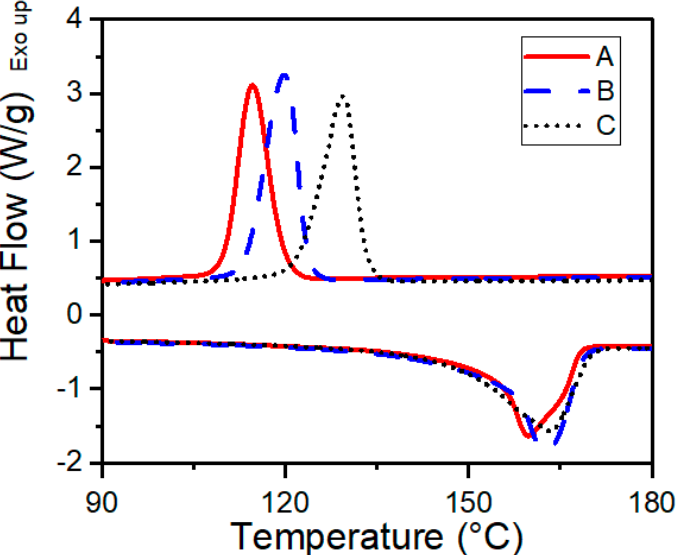
Figure 2. DSC curves for all three resins. Heating and cooling conducted at 10 °C/min.